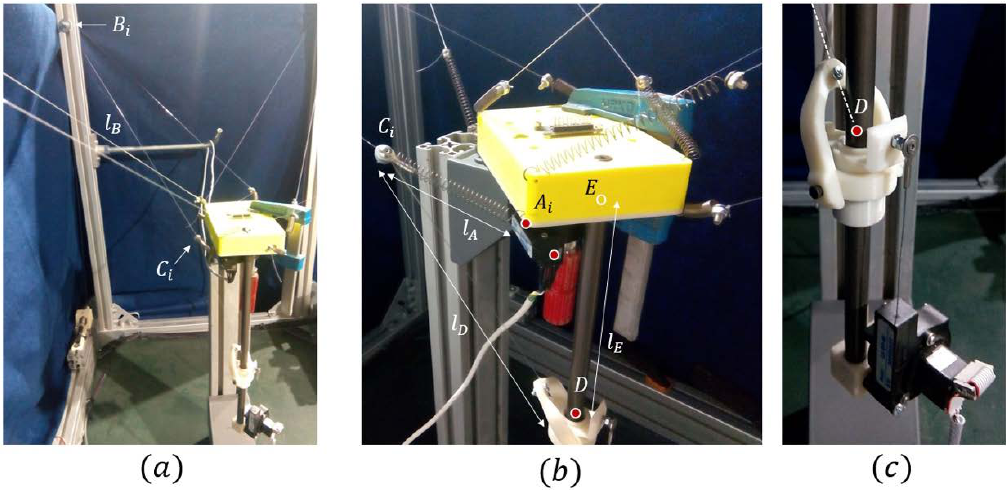
Figure 16. ( a ) General view of the CDPR where it shows point B i where the compliant actuator begins and the controlled length l B ; ( b ) EE 1 with a fixed position, with the compliant actuator coming from the left l B and split in l D attached to EE 2 and l A . It can be seen that l A is made of a spring attached to C i and A i and a thin blue cable inside the spring coming from the linear encoder output (marked with a red dot); ( c ) EE 2 with the central axis of the rod marked with a red dot and the extrapolation of the cable marked with a white discontinuous line.